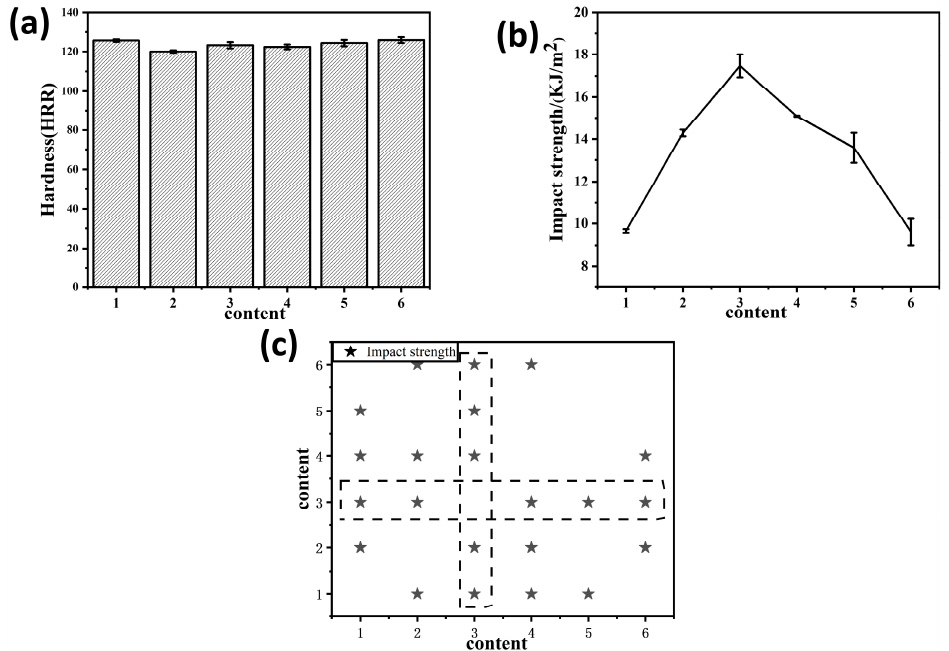
Figure 5. Hardness ( a ) and impact strength curves ( b ) of different types of polyimine composites: polyimine (1), SiCw-1-PI (2), MSiCw-1-MGO-0.2-PI (3), MSiCw-1-MGO-0.3-PI (4), MSiCw-1-MGO- 0.5-PI (5), GO-0.3-PI (6). The statistical significance ( P < 0.05) for the pairwise comparisons of impact strength ( c ) (stars) among the polyimine composites with different reinforcing phases added. Figure 6a–f depicted SEM images of the impact fracture surfaces of the composites with different reinforcing phases added. Similar to the tensile fracture surfaces, the uni- form distribution of MGO and MSiCw increased interfacial binding force on account of the interfacial interactions between the reinforcing phases and the matrix. In addition, MSiCw and MGO were gripped by the matrix before impacting. With the increase of im- pact load, the crack appeared from the matrix and was halted by MGO [Figure 6c]. During the impact process, the broken MSiCw was pulled out against the frictional grip of the matrix and MGO, which improved the impact strength of the composites. Additionally, the cracks can be pinned at the interfaces of the MSiCw/MGO and PI matrix, leading to extra energy dissipation. These phenomena manifest that crack deflection, crack pining, and whiskers pull-out mechanisms were significant tensile strength mechanisms of MGO/MSiCw. Therefore, when the amount of MSiCw and MGO was 1% and 0.2%, the impact strength of the composites reached the maximum. Consistent with the results of the tensile test, excess MGO would lead to a decrease in impact strength, which was pre- sumably caused by the agglomeration of MGO and MSiCw [Figure 6e]. Not only that, the agglomeration and uneven distribution of MGO and MSiCw decreased synergistic en- hancement effects, resulting in the inapparent enhancement effect of the composites.